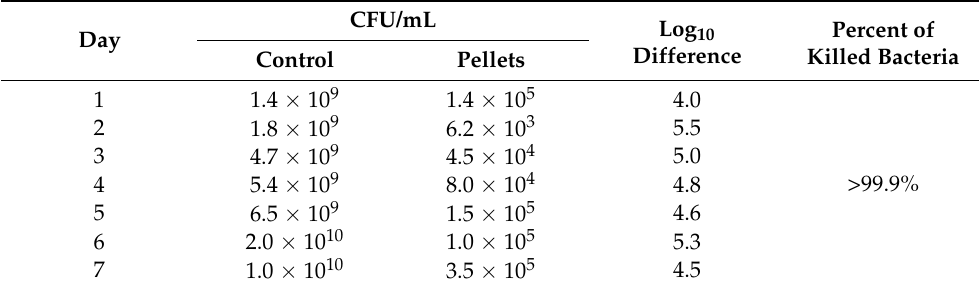
Table 3. The calculated mean values of bacterial concentration (CFU/mL) of control and bacterial culture media were incubated with pellets together with log difference and percentage of killed bacteria after antimicrobial activity